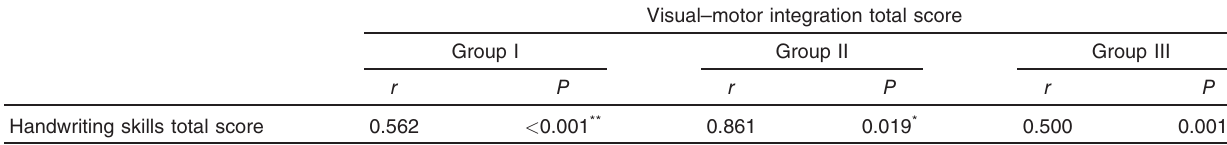
Table 3 Correlation between total score of visual – motor integration and total score of handwriting skills in the three studied groups